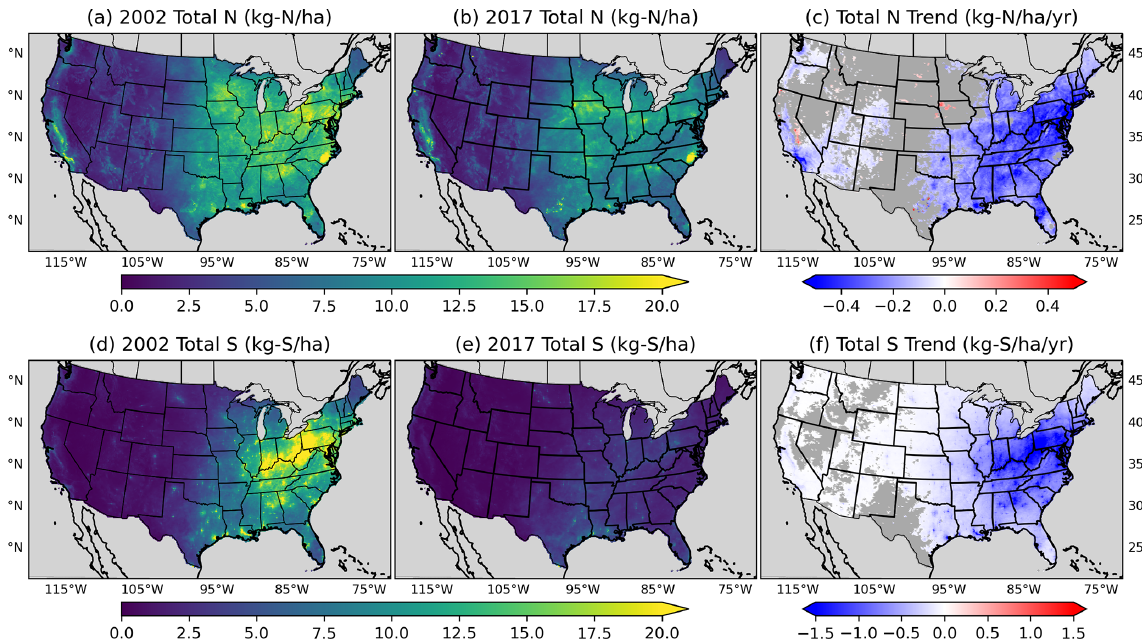
Figure 5. Spatial distribution of total N (a, b, c) and S (d, e, f) deposition in 2002 ( a and d , kgha − 1 ) and 2017 ( b and e , kgha − 1 ) and the 2002–2017 annual trend ( c and f , kgha − 1 yr − 1 ) with significance at the 95% confidence level. Grey areas in panels (c) and (f) indicate where the trend is unavailable due to a lack of PRISM data or not significant (i.e., p value of the Wald test is greater than